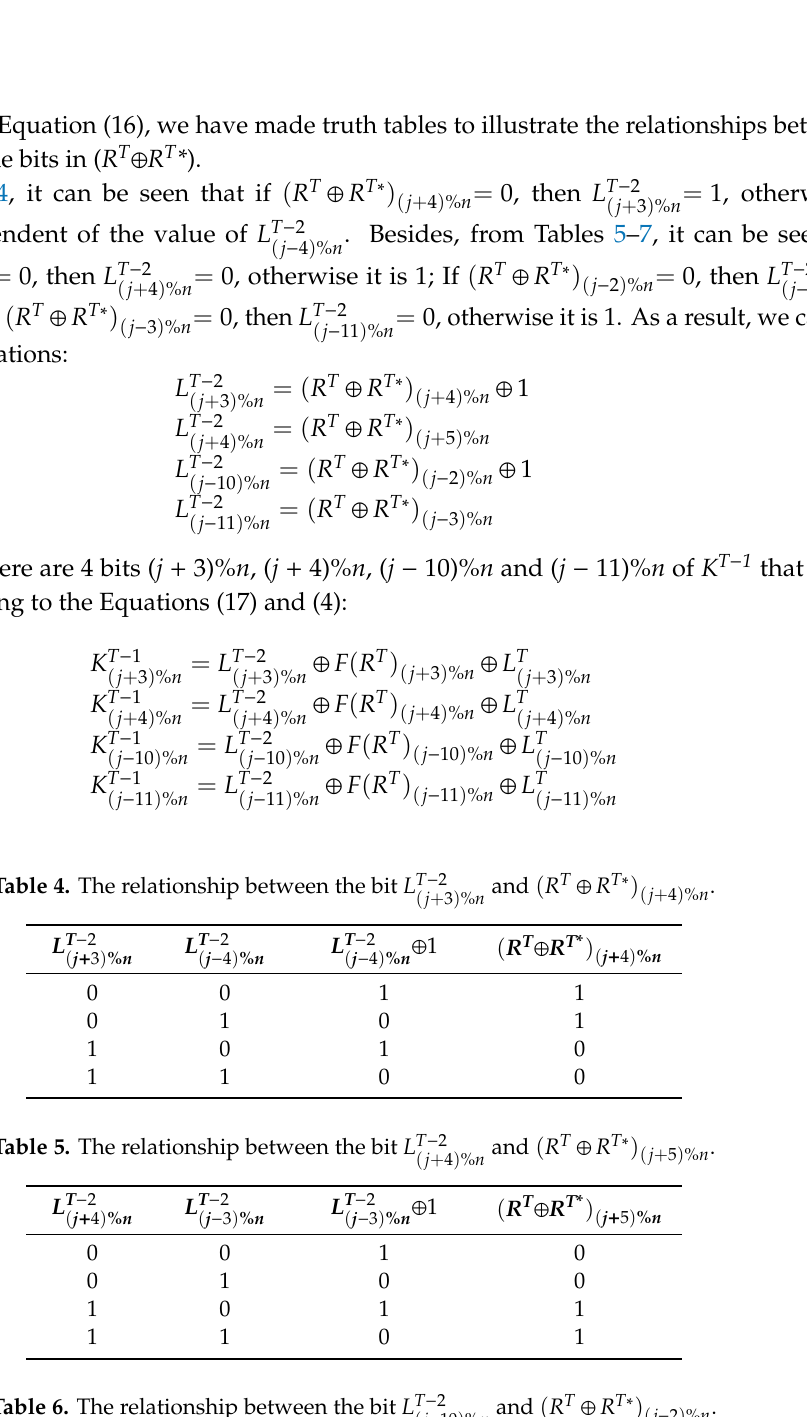
Table 6. The relationship between the bit L T − 2